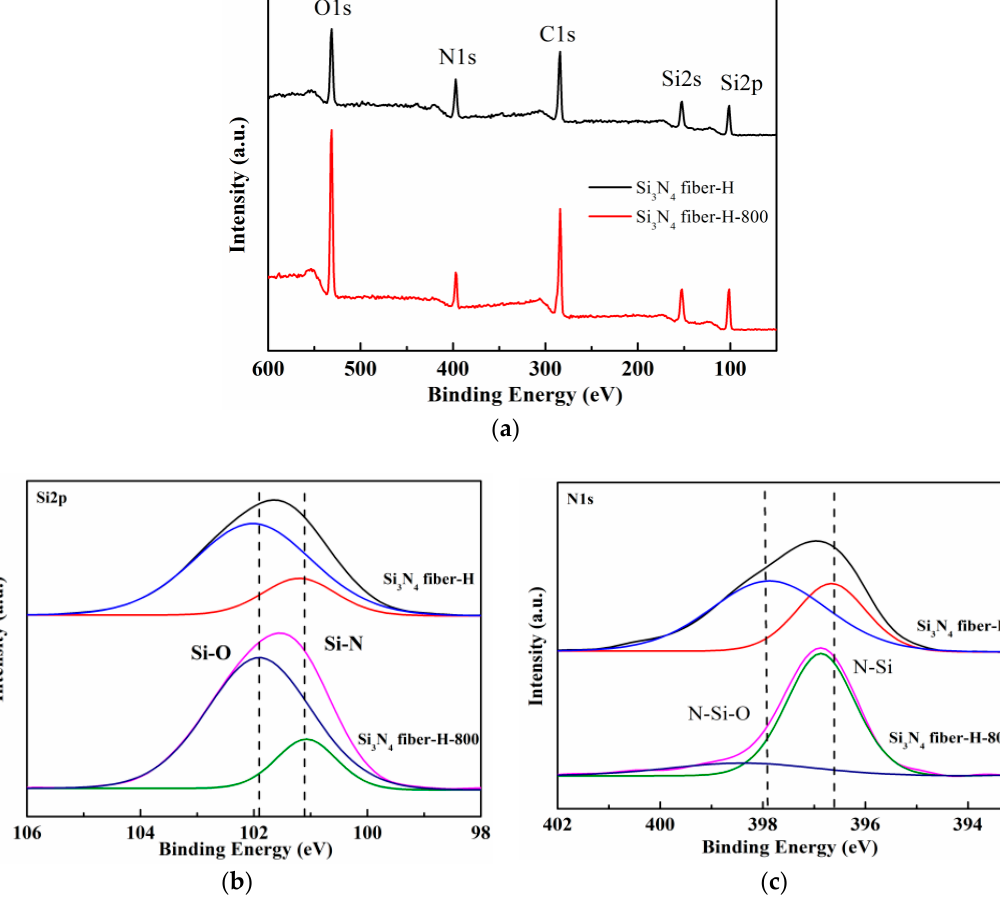
Figure 7. ( a ) XPS survey spectra, ( b ) Si 2p, and ( c ) N 1s core level spectra recorded from Si 3 N 4 fiber-H prior to and following annealing.